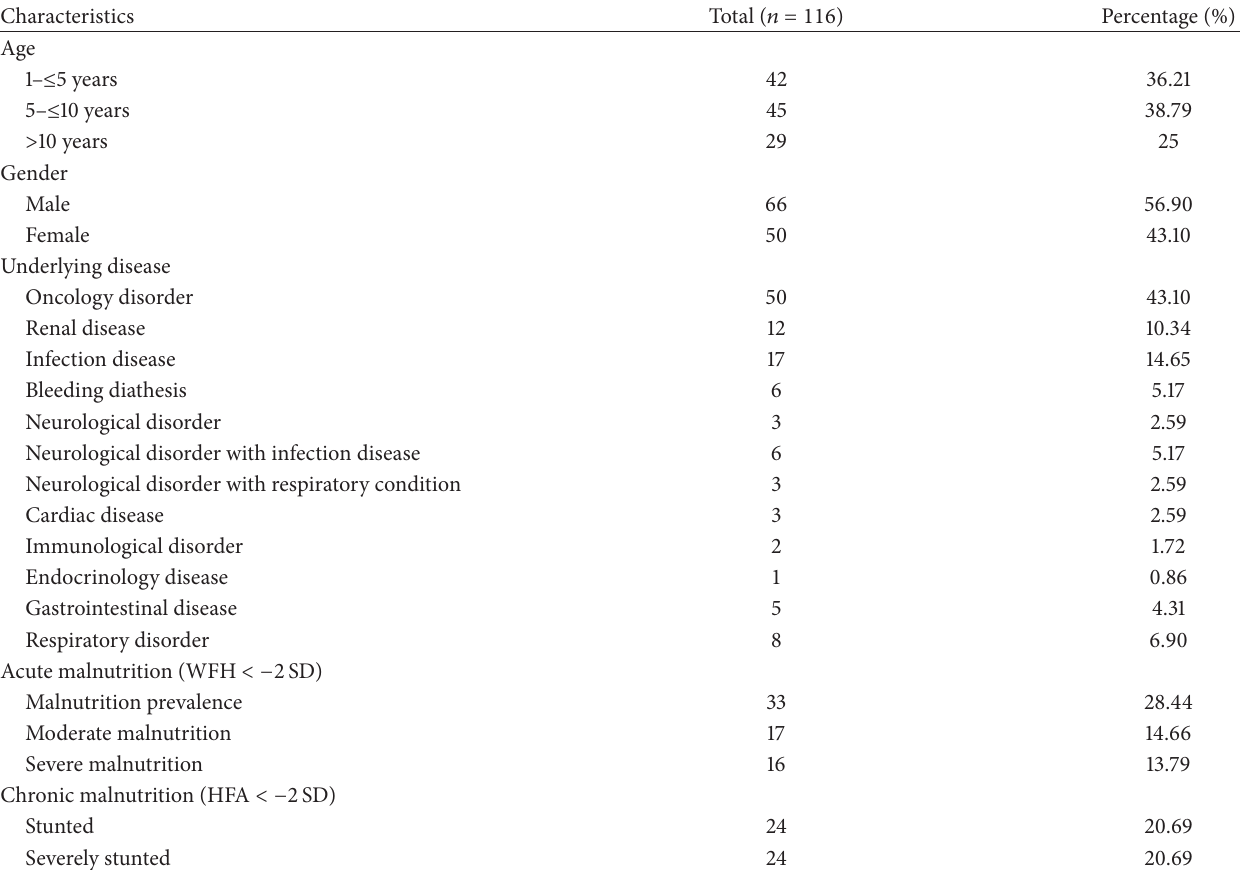
Table 1: Subjects characteristics of the participants.